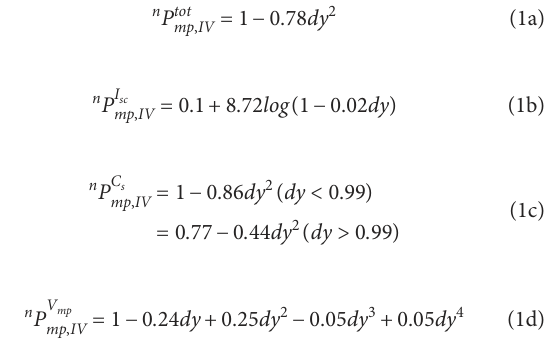
less than 0.01 does not adj